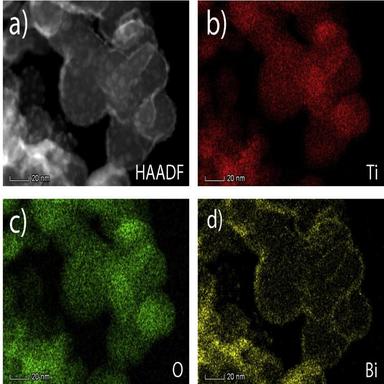
Example of HAADF-STEM-EDS maps of sample P25Bi60: a) HAADF-STEM image; b) Ti mapping; c) O mapping; d) Bi mapping